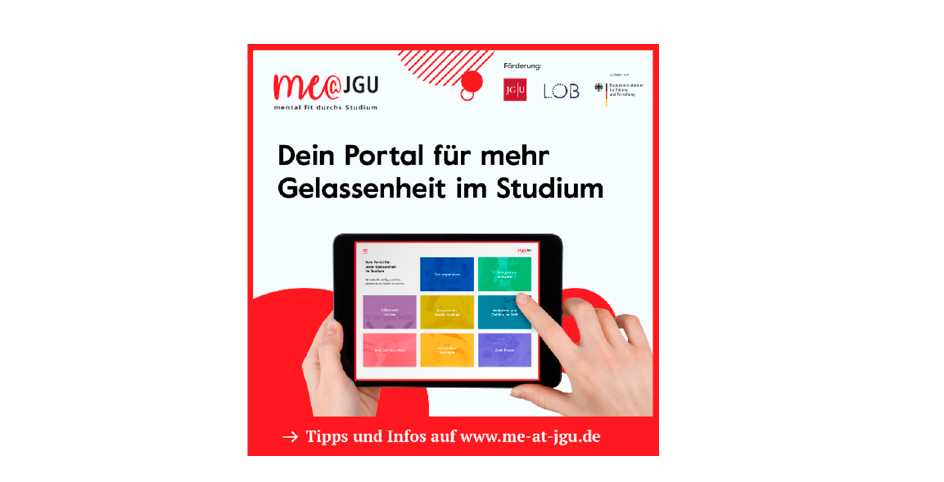
Figure A3. An advertising banner for Social Media.